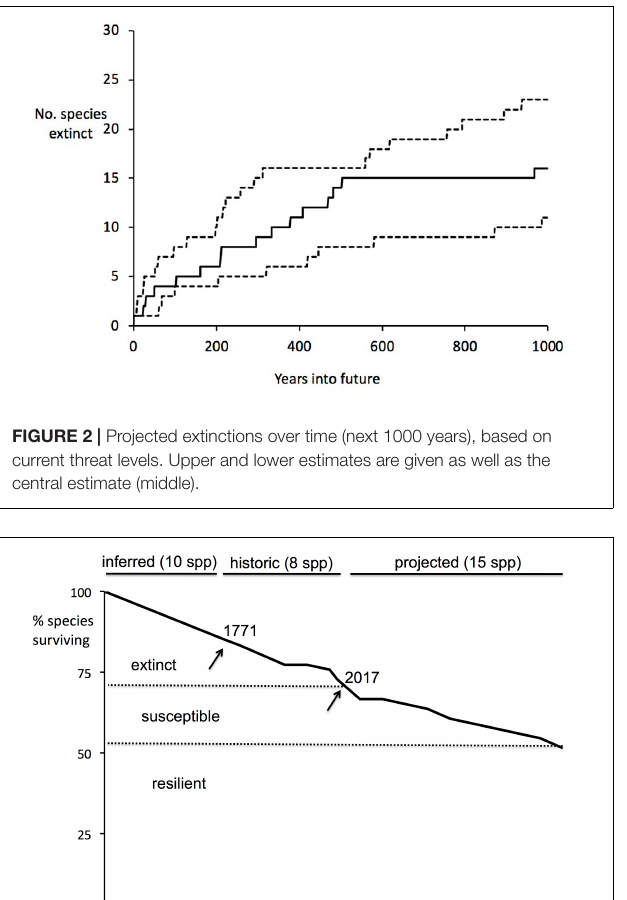
species loss over the same time period, the relationship between HA remaining and species surviving can be determined, i.e.,